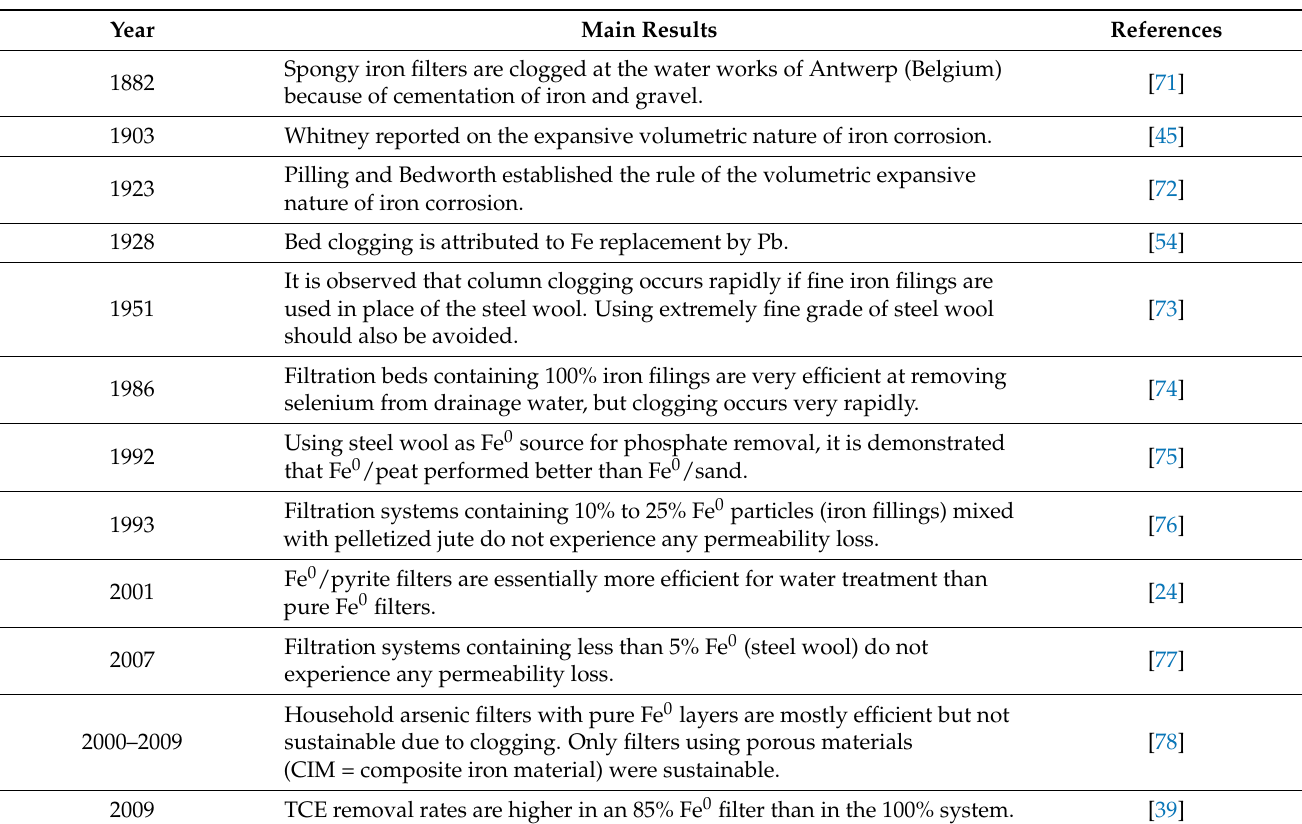
Table 1. Timeline of the main experimental observations relating the importance of porosity loss due to iron corrosion before